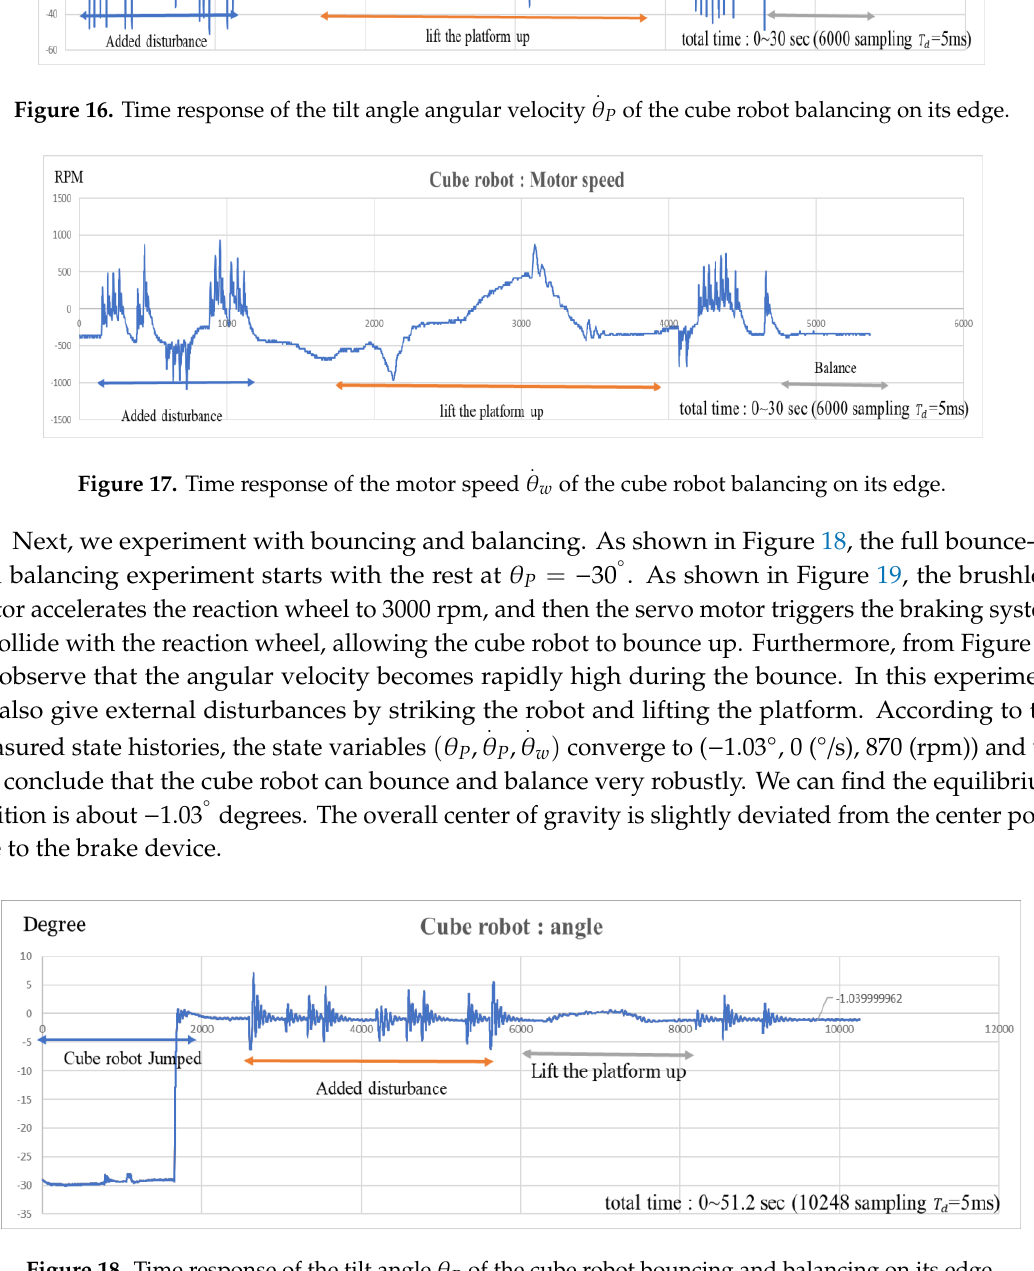
Figure 18. Time response of the tilt angle θ P of the cube robot bouncing and balancing on its